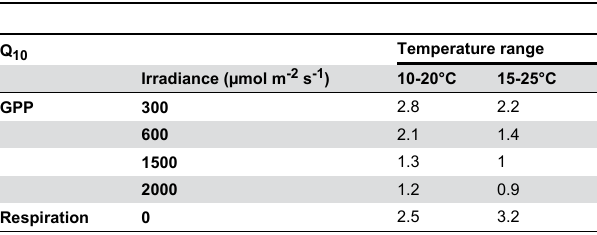
Table 3. Average Q banksii.